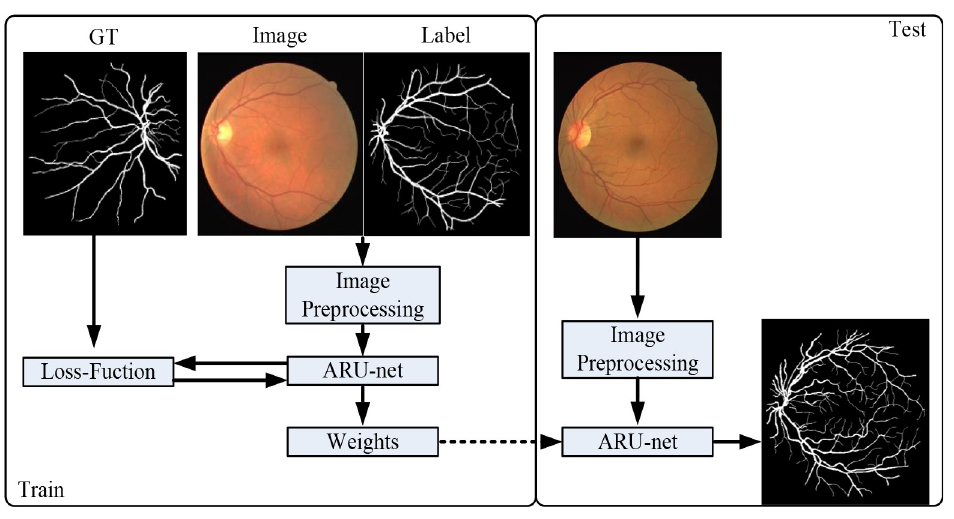
Fig 1. Overview of proposed